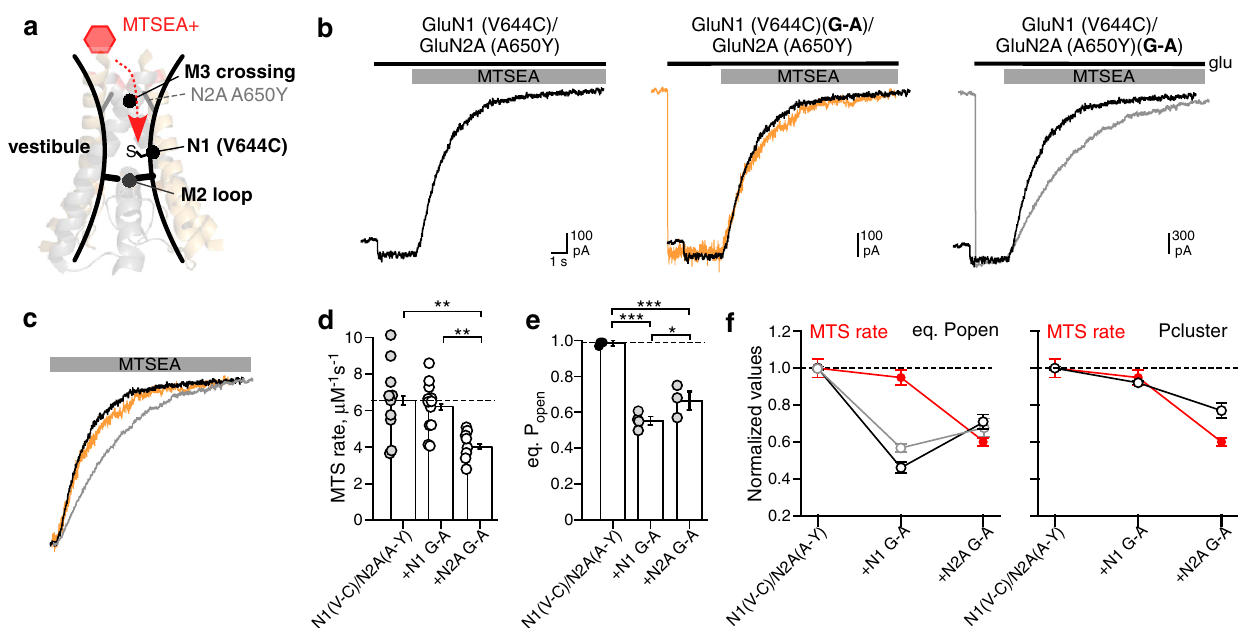
Fig.5|RatesofMTSreactivityindicatethattheM2loopformsagate.a Cartoon illustratingthepositionofGluN1V644inthevestibulebetweentheM3gateandthe M2loop. b Whole-cellrecordingsofconstructscontainingacysteinesubstitutedin the vestibule, GluN1a(V644C), either alone ( left panel ) or with GluN1a(G815A) ( center panel ) or GluN2A(G819A) ( right panel ). Currents were activated by gluta- mate(blackline)andthencellswereexposedtoMTSEA(75 μ M). c AlignedMTSEA- induced current decay for the three constructs. d , e Bar graphs (mean±SEM) for MTS reaction rates ( d ) or equilibrium P open ( e ) for cysteine containing constructs. See Supplementary Table 7 for ns and additional parameters. f Values normalized to control (mean±SEM) for MTS reaction rates (red) and equilibrium P open (left